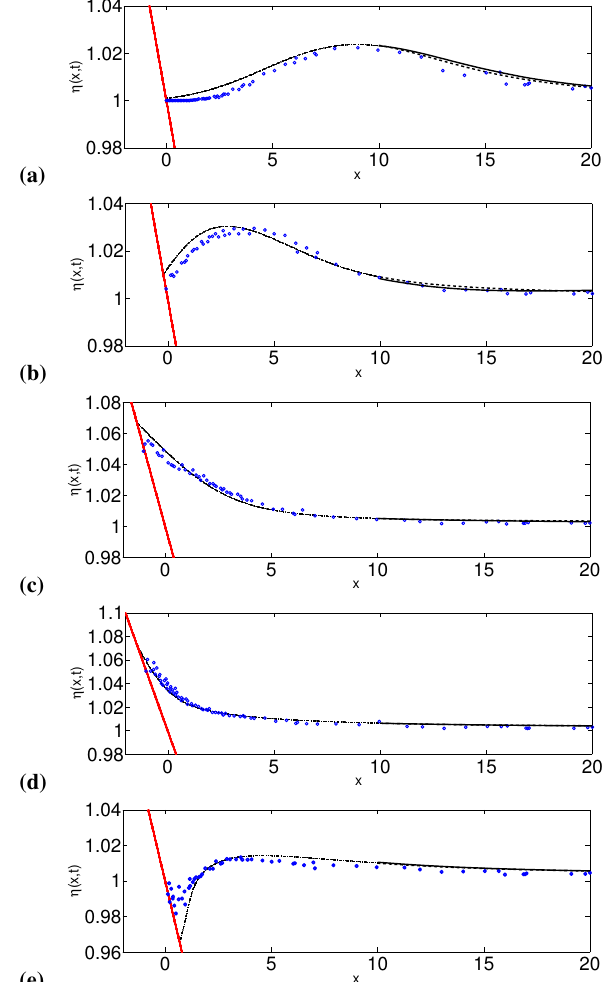
Fig. 3. Run-up of a solitary waves over a canonical bathymetry at Figure 3. Run-up of a solitary wave over a canonical bathymetry times (a) t = 30 , (b) t = 40 , (c) t = 50 , (d) t = 60 , (d) t = 70 . The at times (a) t = 30, (b) t = 40, (c) t = 50, (d) t = 60, and (e) t = solid line is LSWE with EBC implementation at x = 10 , the dashed 70. The solid line is LSWE, with EBC implementation at x = 10, and dotted-dashed lines are the coupling of LSWE and NSWE the dashed and dotted-dashed lines are the couplings of the LSWE model respectively, and the symbols are laboratory data of Syno- and NSWE models, respectively, and the symbols are the laboratory lakis (1987). data of Synolakis